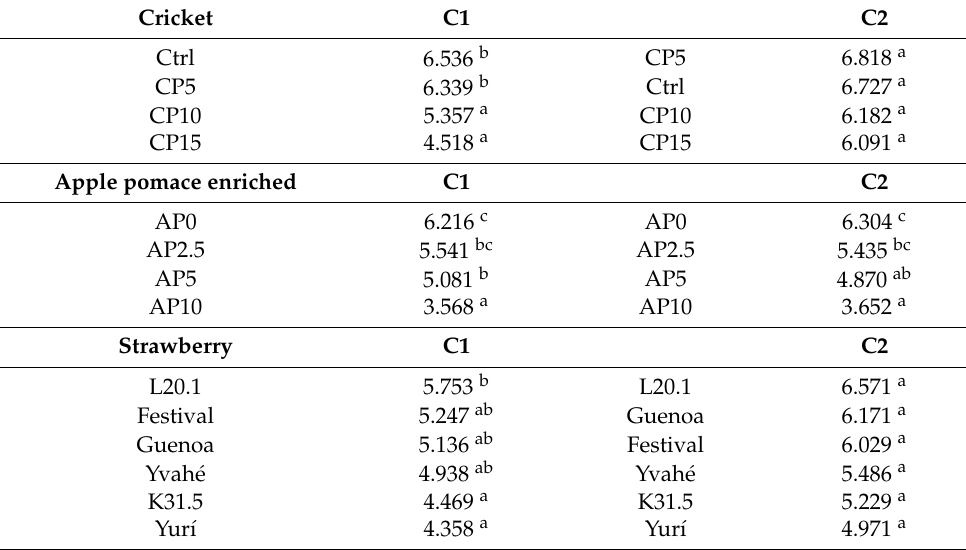
Table 4. Analysis of variance and Tukey post-hoc tests of overall liking variable conducted on the two clusters separately for all three product groups. Letters indicate homogeneous subgroups determined by Tukey post hoc test. C1 indicates the cluster achieving lower average similarity values, e.g., having better discrimination ability. Cricket C1 C2